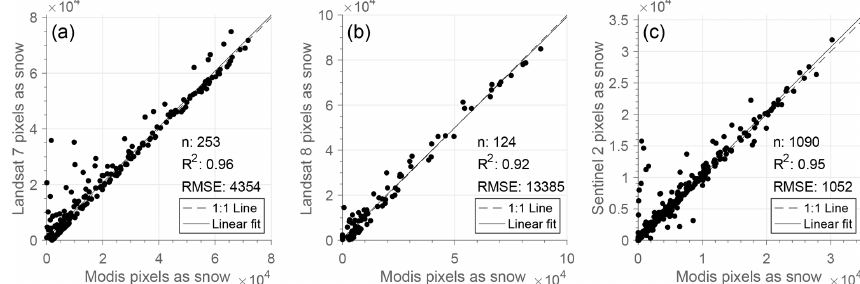
Figure 5. Relationship of classified snow pixels for Landsat 7/8 and Sentinel 2 with the MCDAT product.